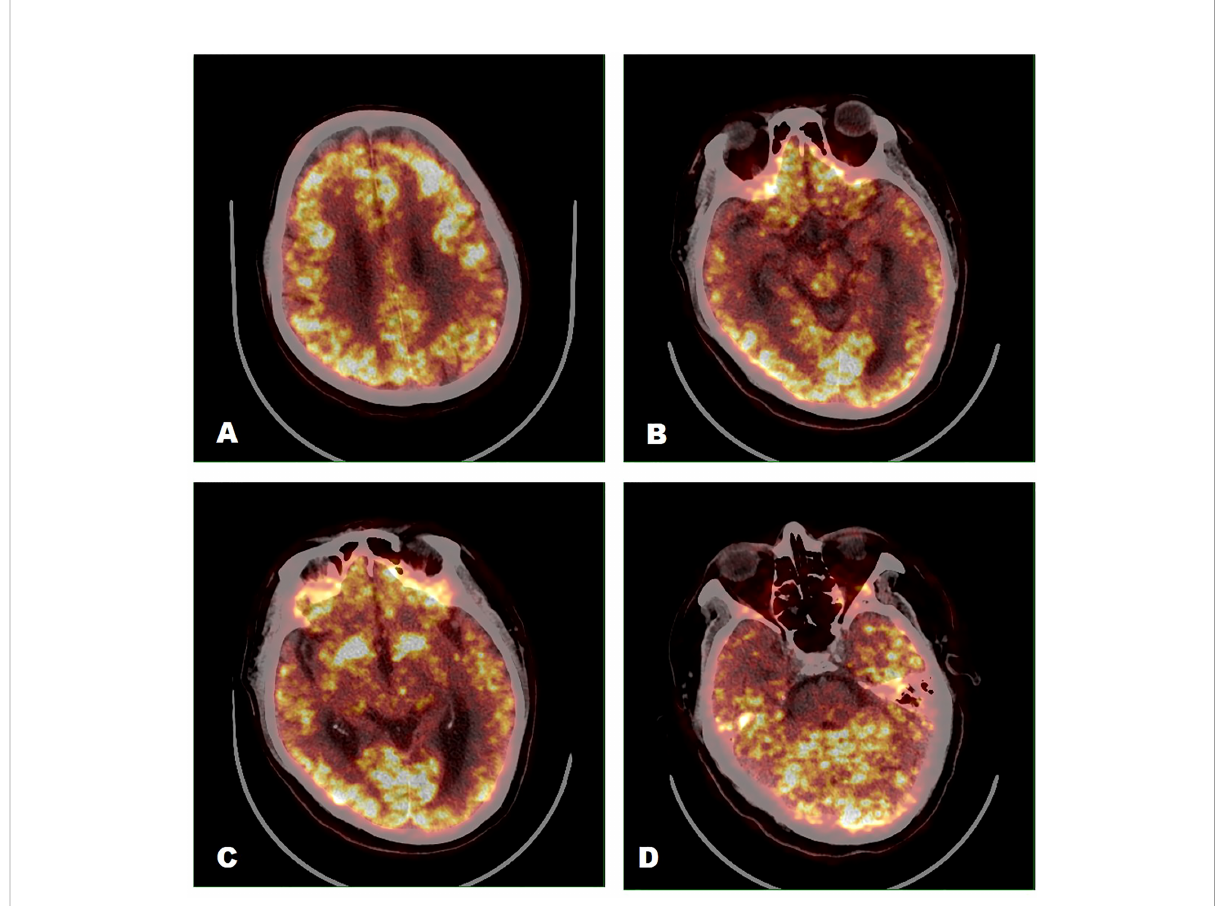
FIGURE 5 18 F-FDG PET/CT image fi ndings (Patient 18). Signi fi cantly lower FDG metadata levels were observed in the left parietal (A) , occipital (C) , parahippocampal gyrus (B, D) , and dorsal thalamus (C)